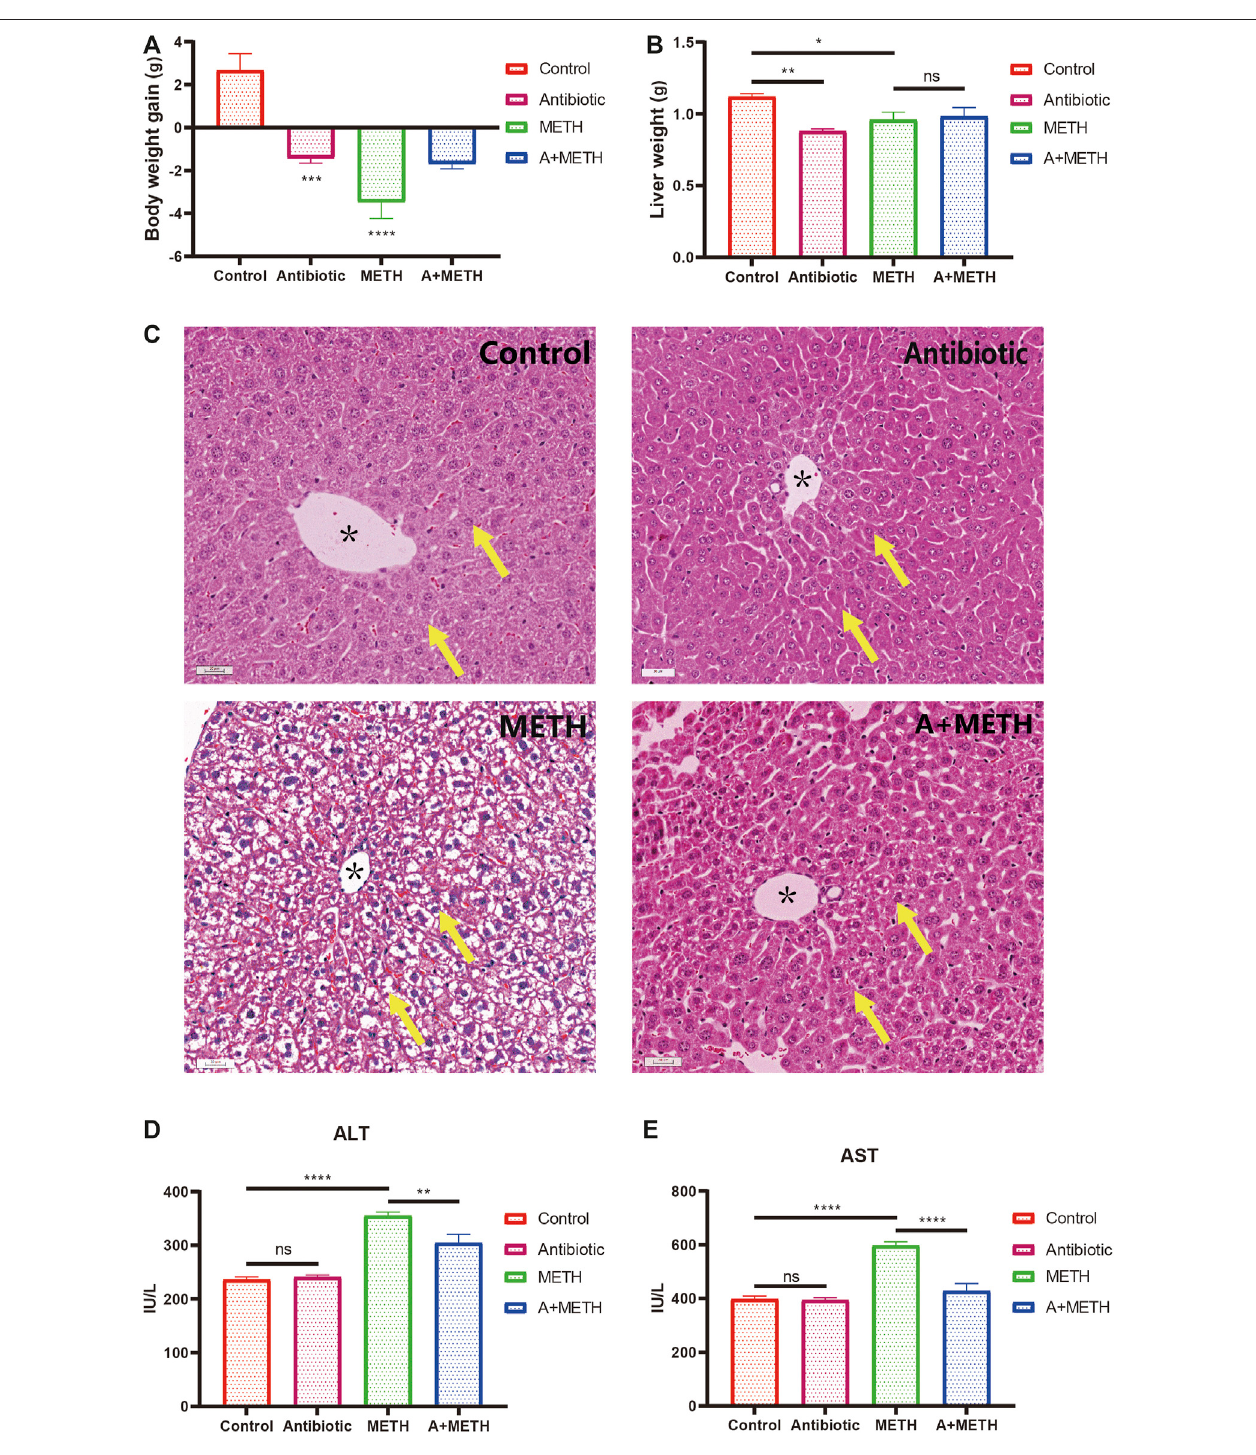
FIGURE 1 | Changes in body weight (A) and liver weight (B) of mice compared with the control group. Histopathological assessment of METH liver injury (C) . The yellow arrows point to the nucleus and cytoplasm; * indicates the central vein; bar (cid:2) 20 μ m, 20 × . METH signi fi cantly enhanced serum ALT (D) and AST (E) activities relative to the control group. The increasing level was attenuated in the A + METH (antibiotic + METH) group. * p < 0.05; ** p < 0.01; *** p < 0.001; ns, statistically non- signi fi cant.